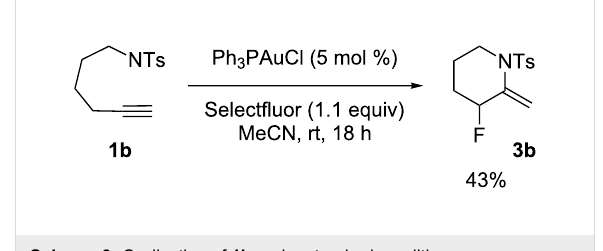
Scheme 3: Cyclization of 1b under standard